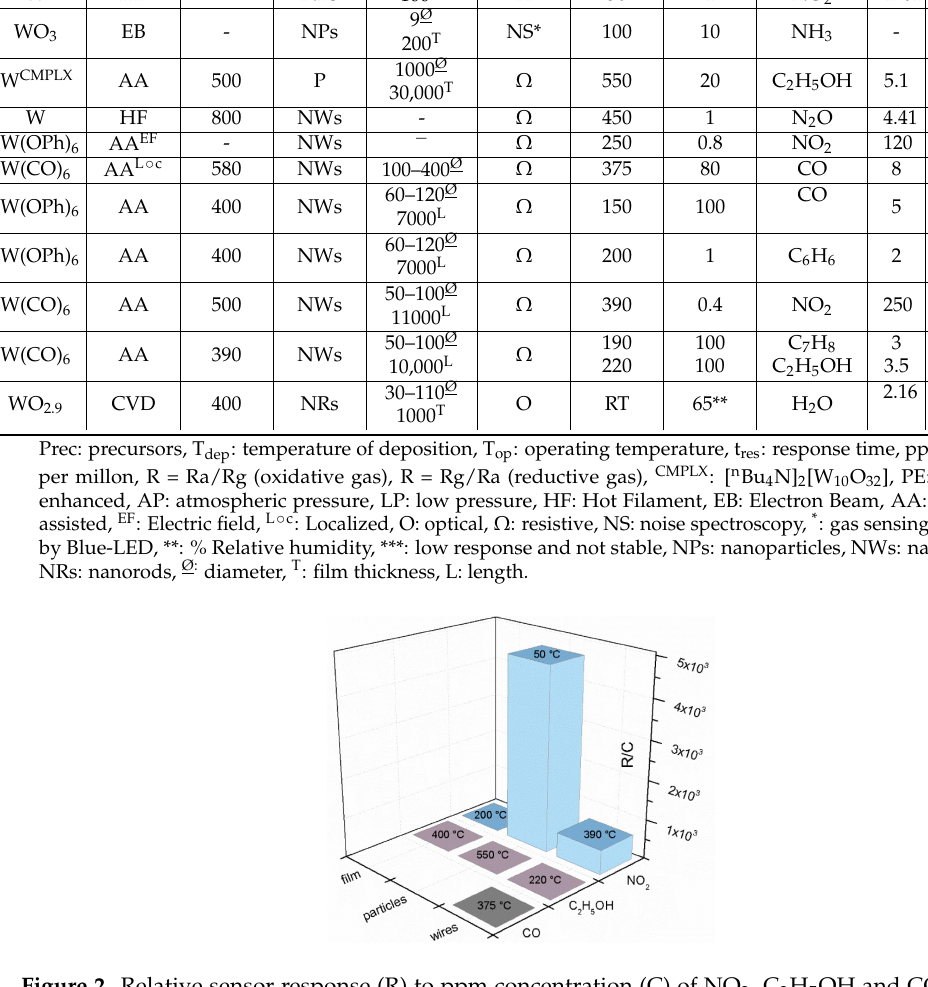
Figure 2. Relative sensor response (R) to ppm concentration (C) of NO 2 , C 2 H 5 OH and CO against operating temperature for different tungsten oxide morphologies (based on the maximum response for the minimum concentration in Table 1 for each morphology/gas